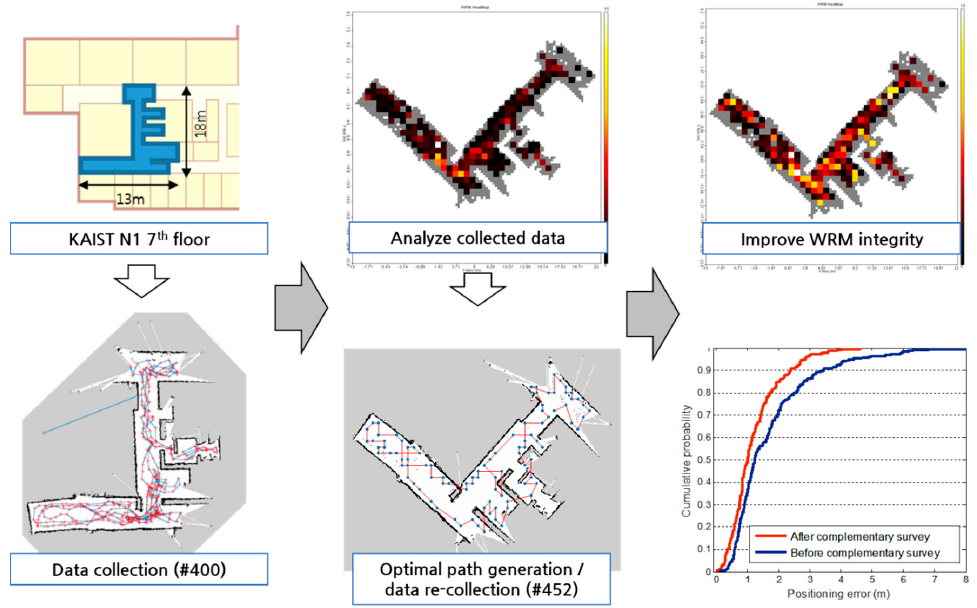
Figure 9. Wi-Fi fingerprint collection/recollection process of the test area.